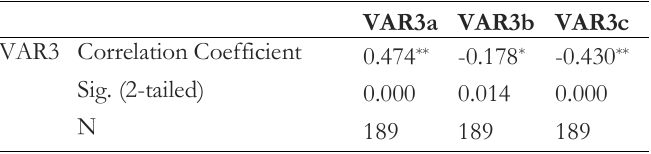
Table 6. Correlation among neutrosophic item 3 and classical item 3.